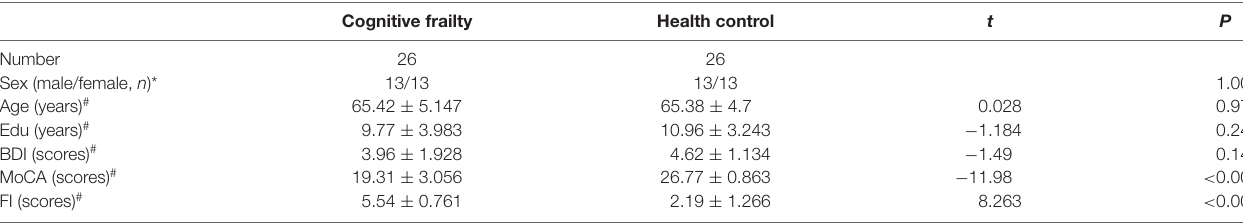
TABLE 1 | Demographic and cognitive and physical frailty data of two groups. Cognitive frailty